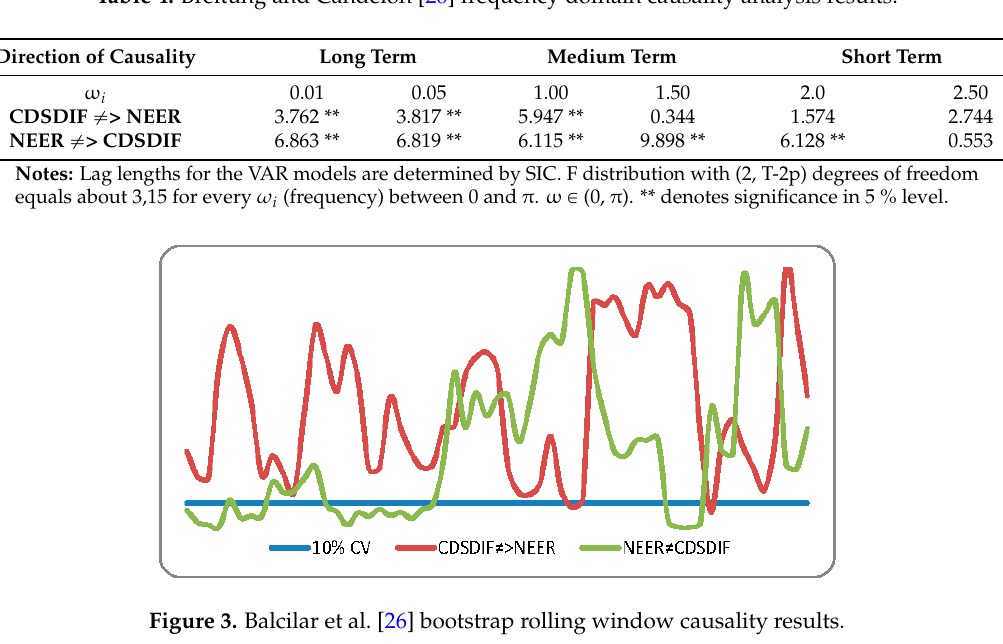
Table 4. Breitung and Candelon [26] frequency domain causality analysis results.